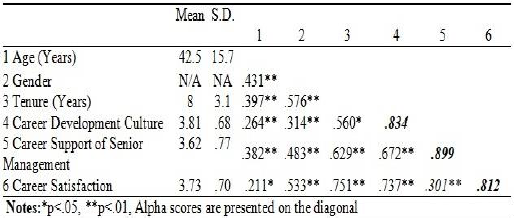
Table 5: Correlation Matrix of Variables